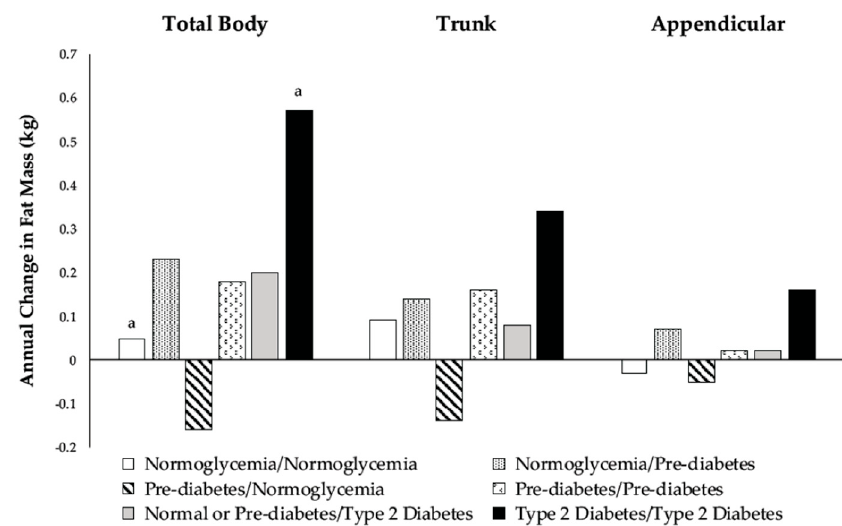
Figure 2. Adjusted marginal means of annual change from baseline in total body ( p = 0.02), trunk ( p = 0.06), and appendicular ( p = 0.06) fat mass according to categories of glycemic status during the three-year follow-up. Model included baseline age, height, population group, percent time in moderate-plus-vigorous activity, average caloric intake, baseline measures of fat and lean mass in the specific body compartment (total body, trunk, or appendicular), changes in percent time in moderate-plus-vigorous activity and average caloric intake, and annual change in lean mass of the same compartment. Means with similar superscripts are different using post hoc contrast tests based on hypotheses.